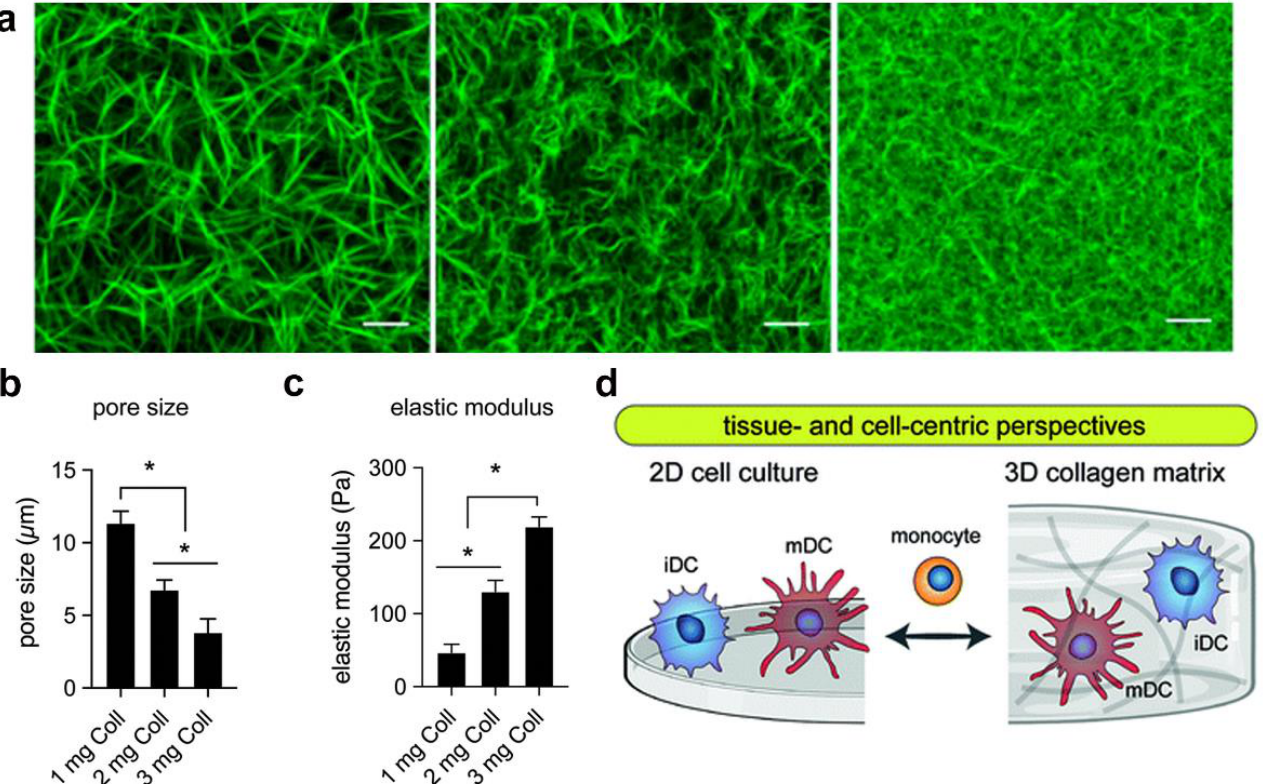
Figure 7. Collagen hydrogel matrices for DC culture. ( a ) Collagen hydrogels with different fibrillar microarchitectures (reprinted/adapted with permission from Ref. [12], 2020, Sapudom et al.) ( b ) Topological and ( c ) mechanical properties of collagen matrices with various concentrations (* significance level of p < 0.05). ( d ) Schematic diagram of a collagen hydrogel for DC culturing (Reprinted/adapted with permission from Ref. [60], 2017, Xie et al.) .